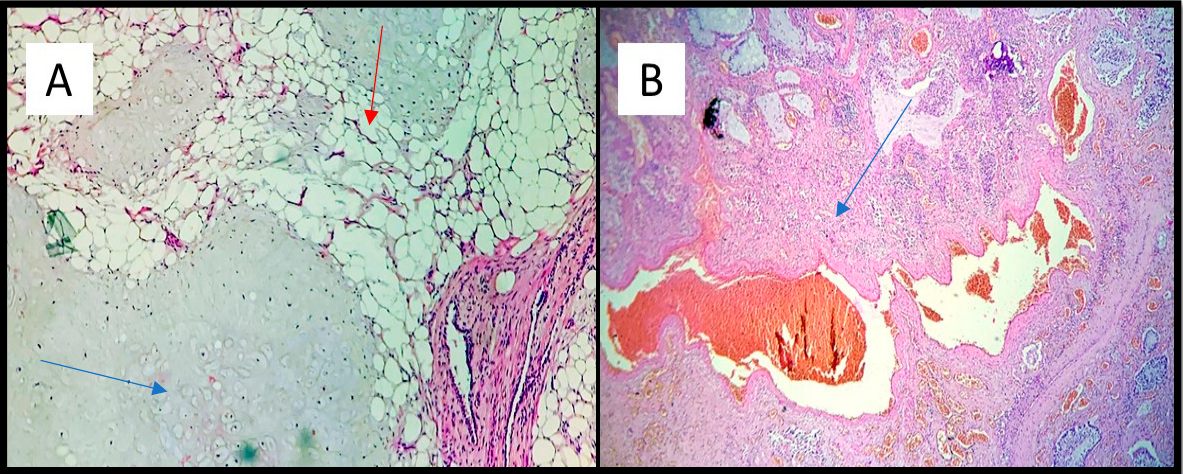
Figure 4. ( A ) Three components of pulmonary hamartoma: Cartilage (blue arrow), adipose tissue (red arrow), and vascular tissue (hematoxylin ‐ eosin, original magnification: 10×). ( B ) Abnormal presence of arterial and venous vascular tissue. Note the presence of thrombus and chronic flogistic infiltration outbreaks (blue arrow) (hematoxylin ‐ eosin, original magnification 10×).